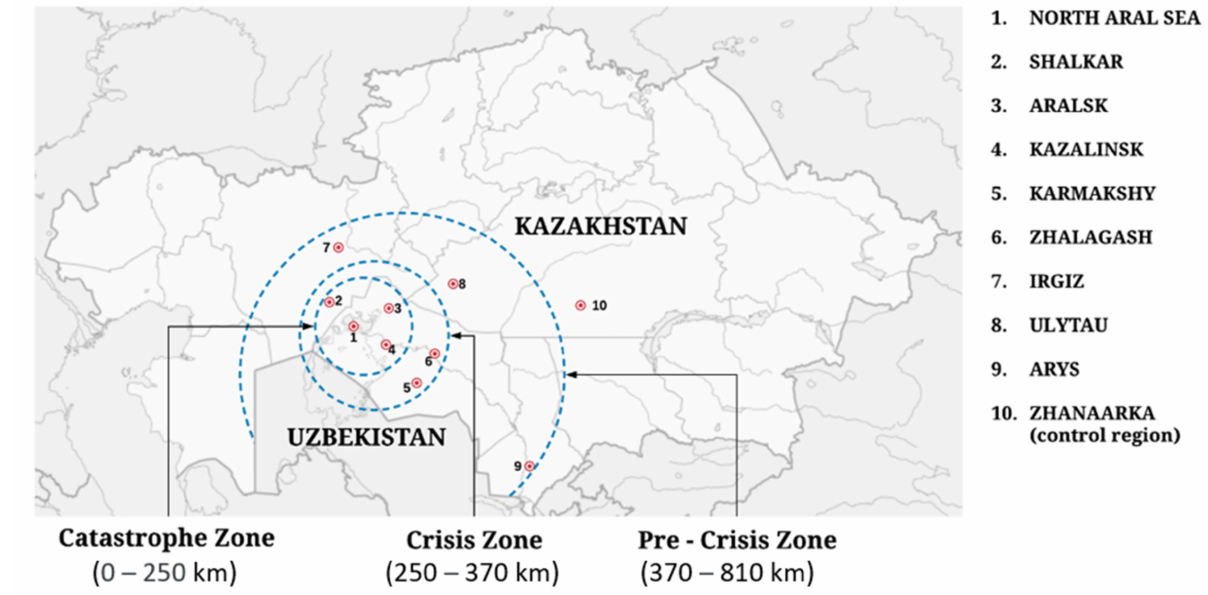
Figure 3. The study area of the Aral region in Kazakhstan, Kyzylorda